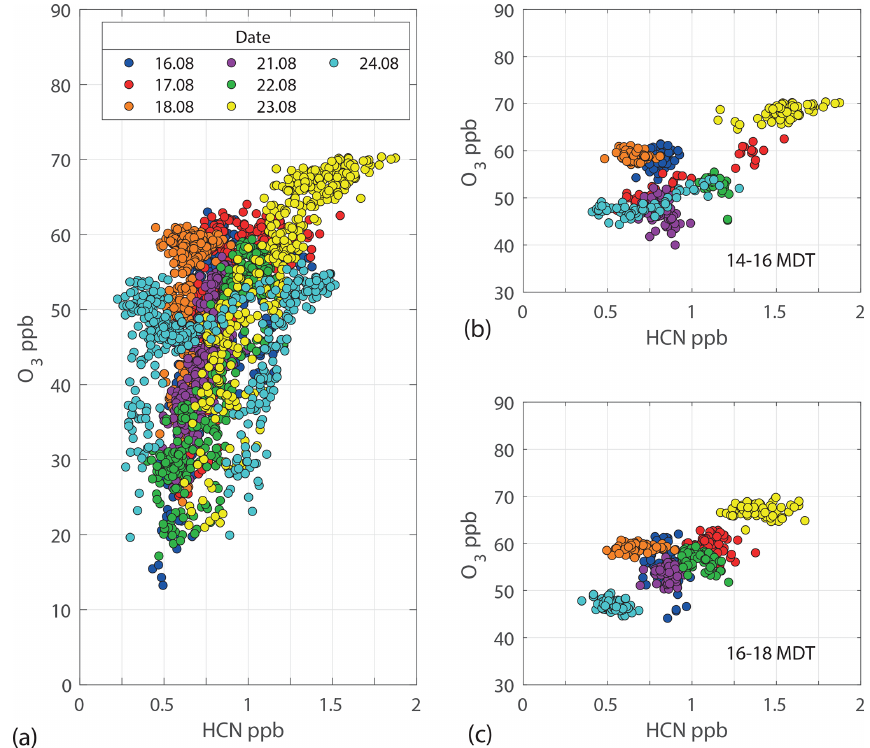
Figure 4. Correlation between O 3 and smoke tracer HCN for all observations between 09:00 and 22:00MDT (a) , 14:00 and 16:00MDT (b) , and 16:00 and 18:00MDT (c) . Data points are colored by date